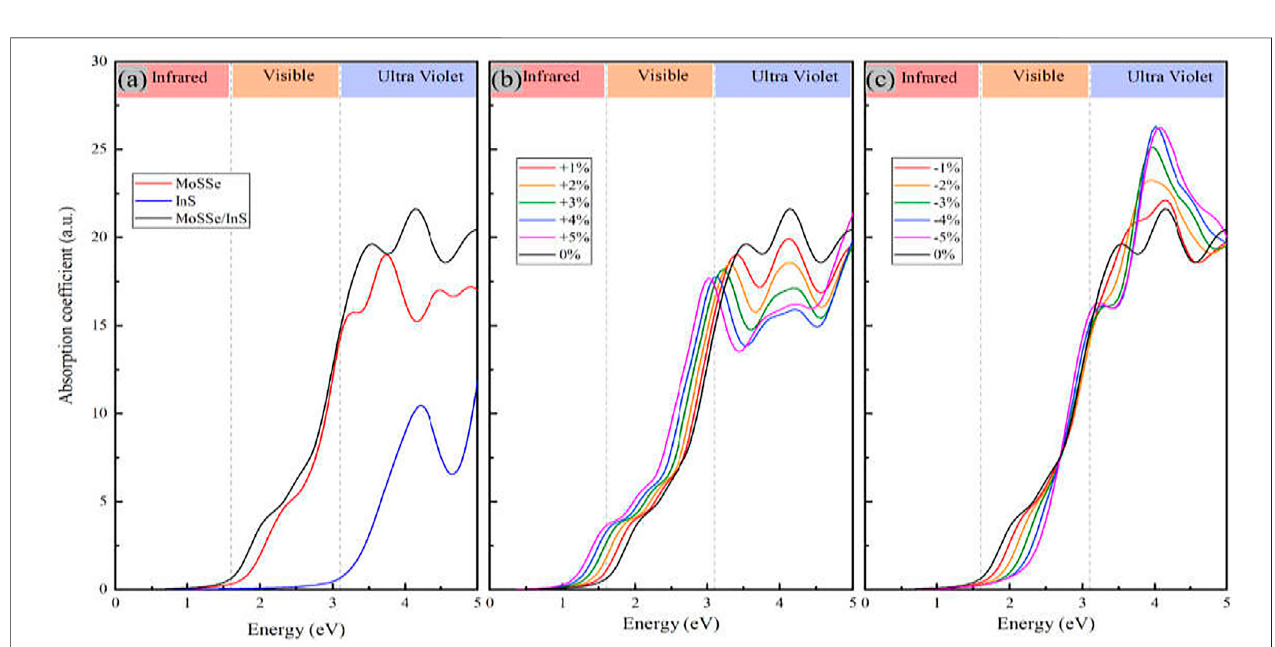
FIGURE6|(A) TheopticalabsorptionspectraofMoSSemonolayer, InSmonolayerandtheMoSSe/InS vdWHs, (B,C) correspondtothecaseswithtensionstrain and compressive strain, respectively.